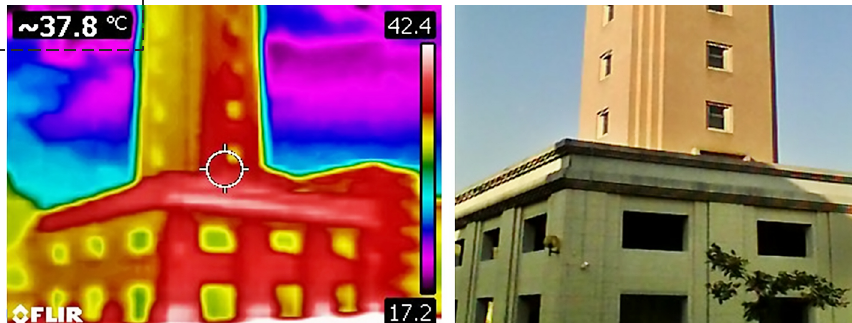
Figure 3. Infrared thermal imager detection case: detection of exterior wall peeling (infrared and visible